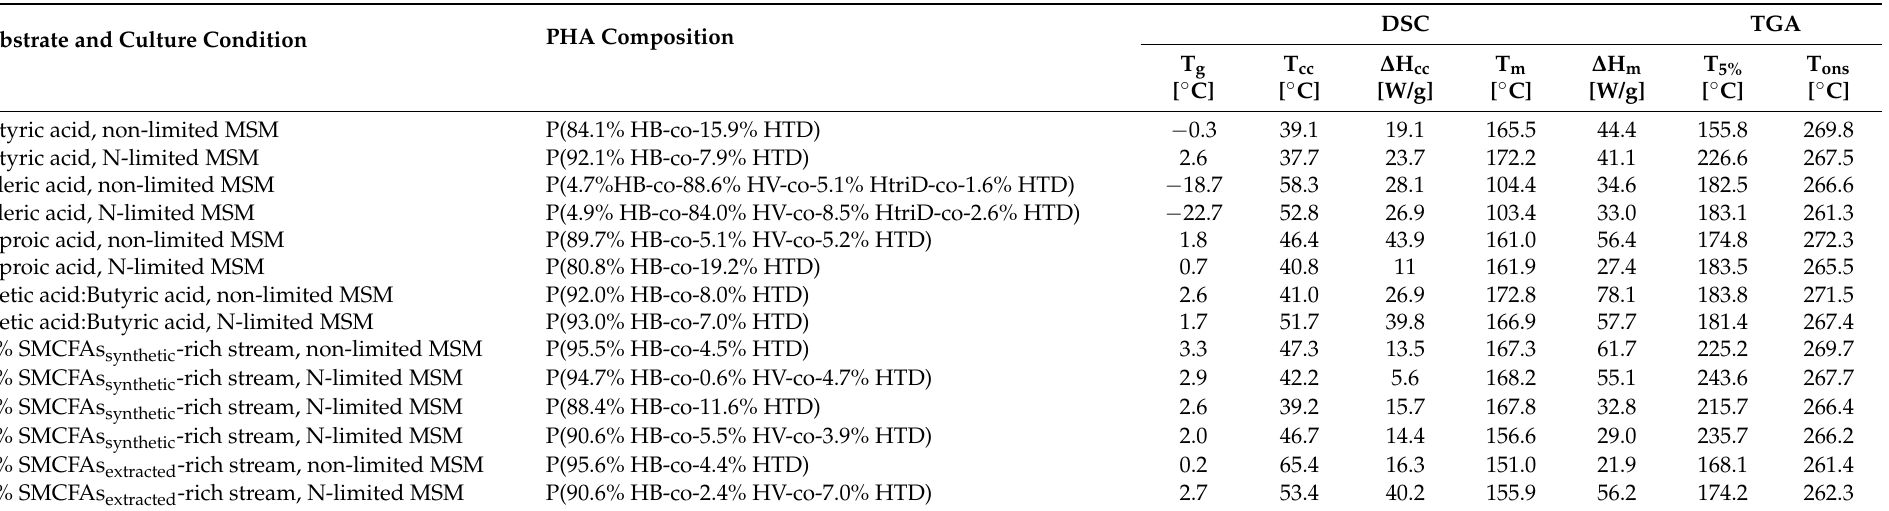
Table 5. Differential scanning calorimetry (DSC) and thermogravimetry (TG) results of the produced PHAs extracted from Aeromonas sp. AC_01 cells grown